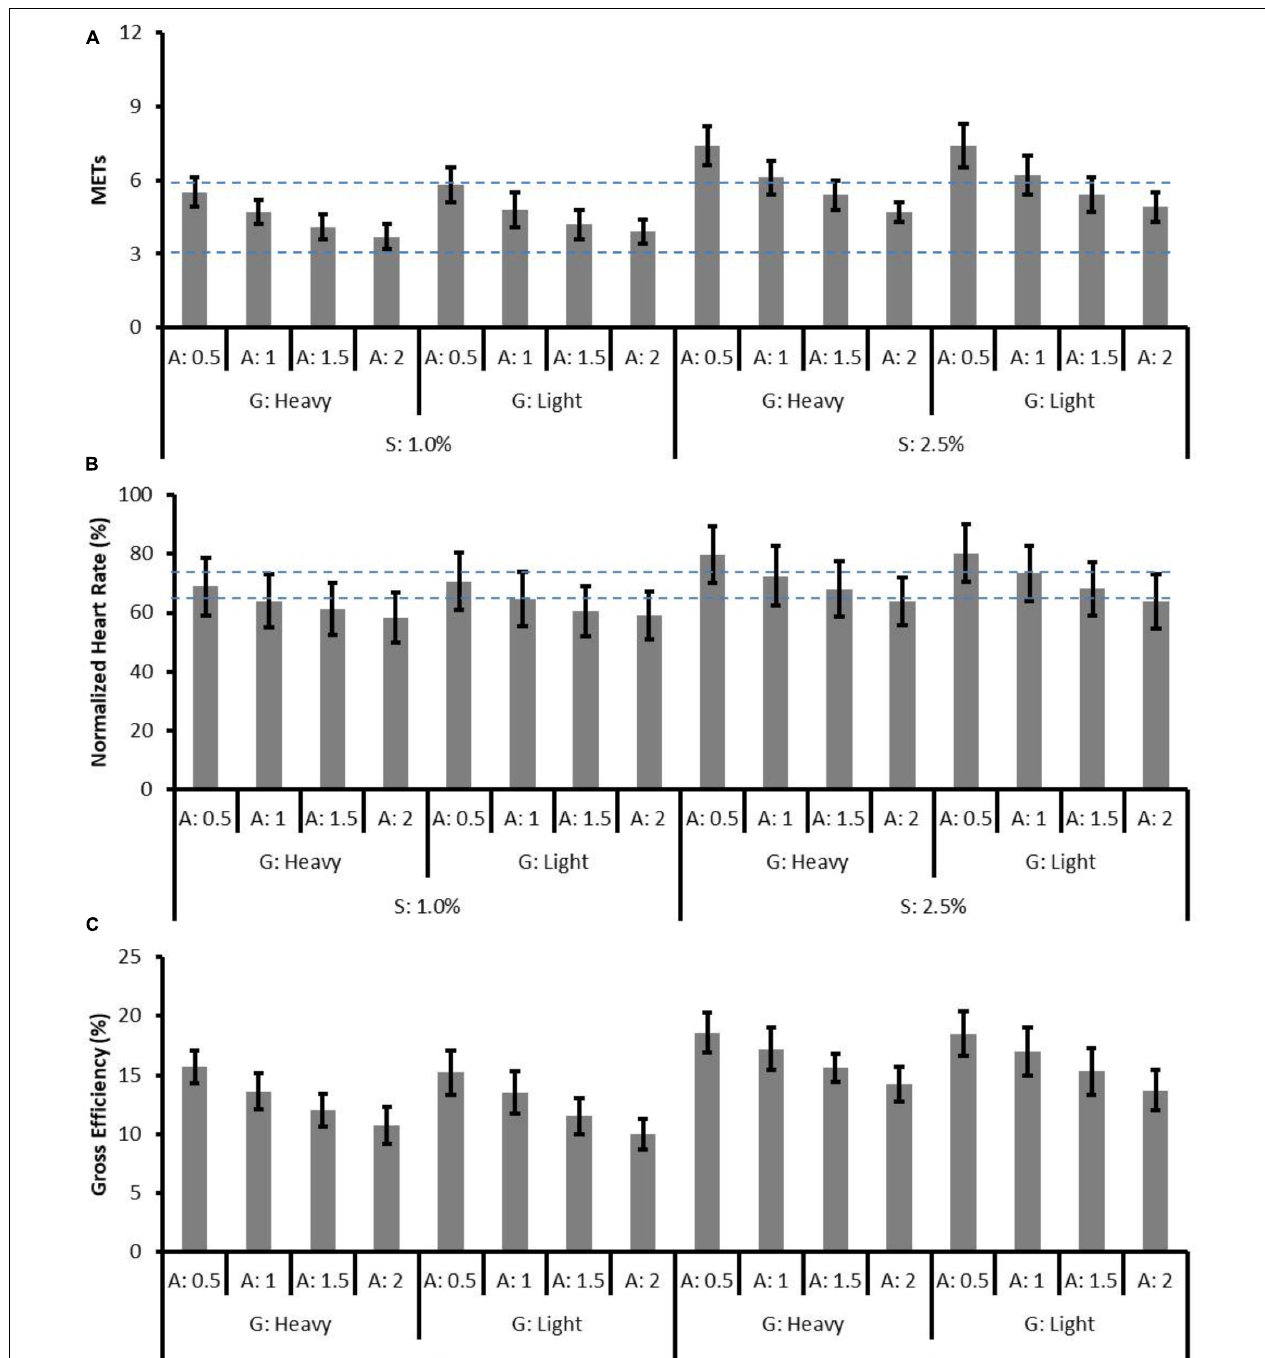
FIGURE 2 | The means and standard deviations of (A) MET, (B) normalized heart rate (%), and (C) gross efficiency (%) in all conditions. S, slope; G, gear ratio; A, assistive level. The horizontal dashed lines represent the upper and lower bound of moderate level defined by ACSM.